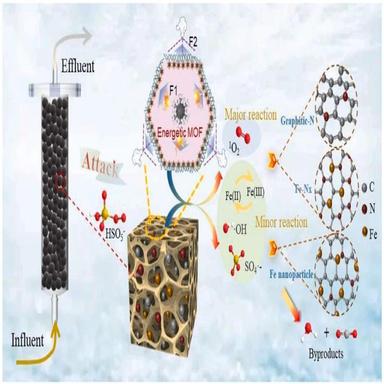
Possible mechanism of TTCH degradation in the PMS/EMFe0.2S system.